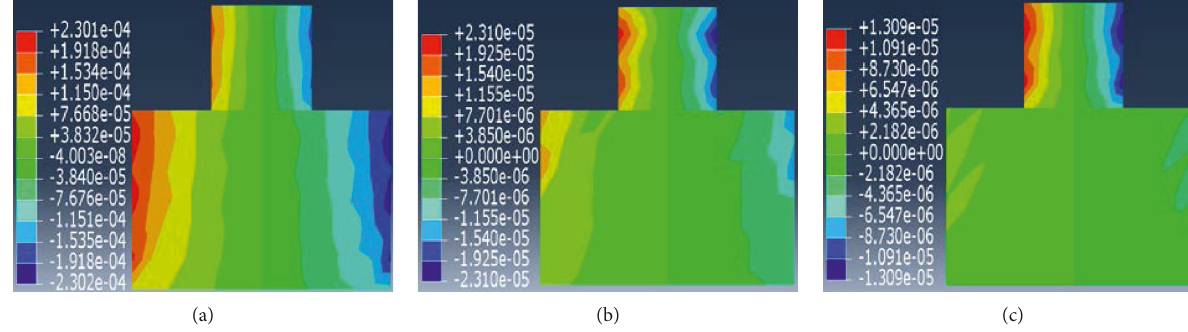
Figure 17: Lateral displacement of a concrete footing, during concrete footing-soil foundation interaction. (a) Footing not embedded. (b) Half of the footing embedded. (c) Full of footing embedded.